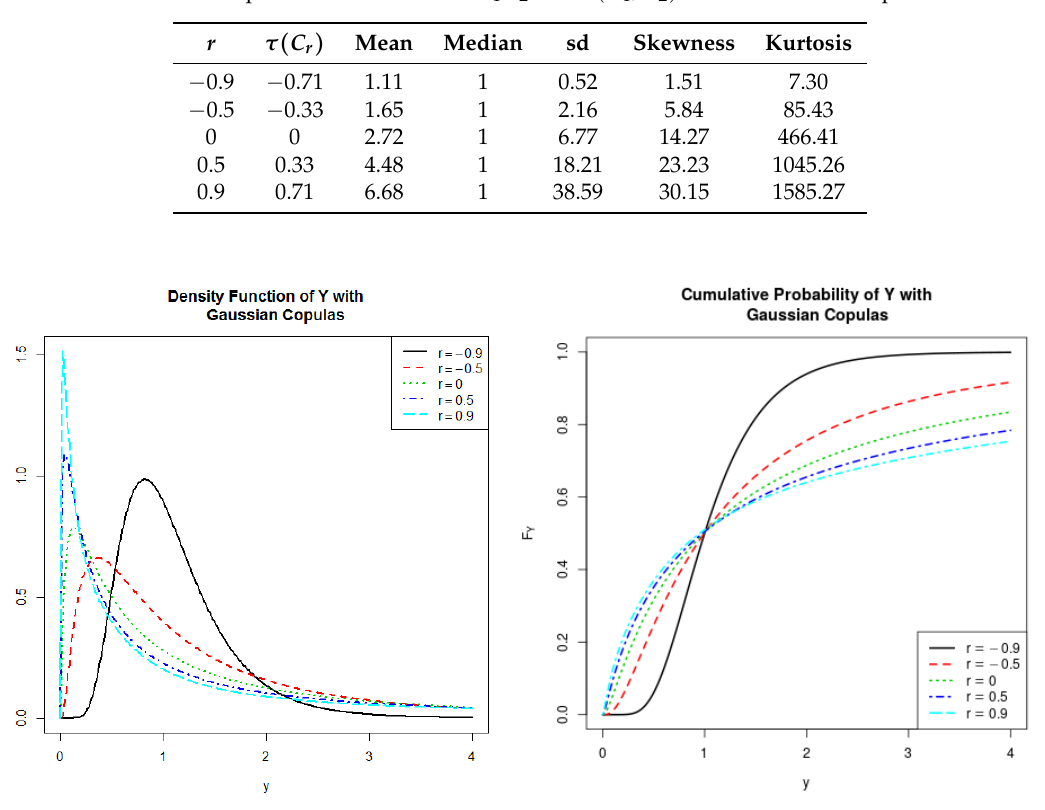
Table 1. Descriptive Statistics for Y = X 1 X 2 when ( X 1 , X 2 ) follows Gaussian copulas.